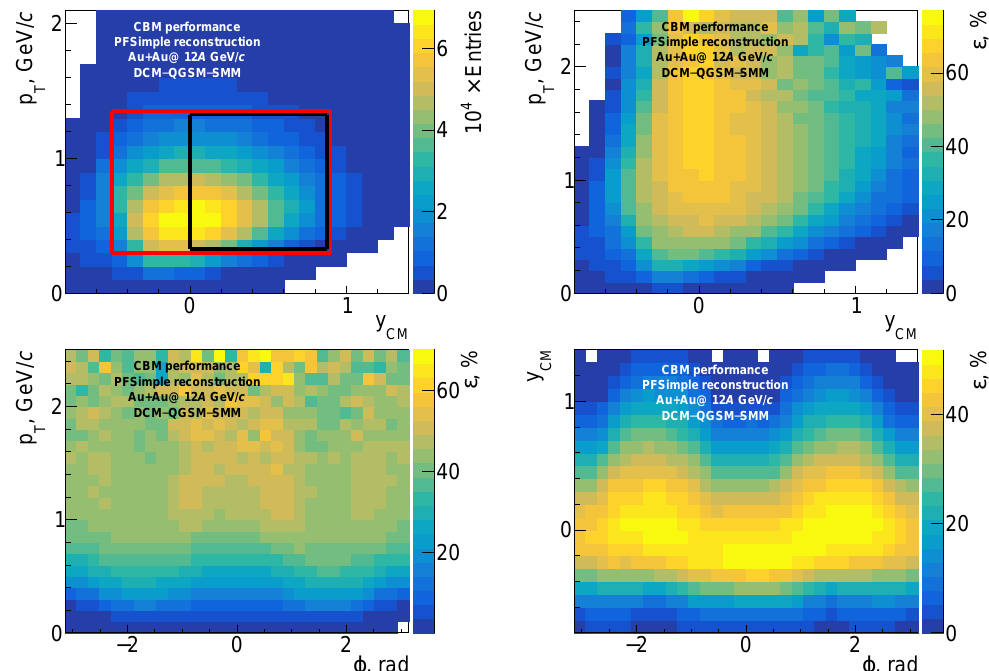
Figure 3. ( top left ) Population of reconstructed Λ hyperons vs. p T , Λ and y Λ . The kinematic ranges for which v 1 vs. y Λ ( p T , Λ and centrality) were calculated are indicated by the red (black) rectangle. Reconstruction efficiency for the Λ → p π − decay channel ( top right ) vs. p T , Λ and y Λ , ( bottom left ) vs. p T , Λ and ϕ Λ and ( bottom right ) vs. y Λ and ϕ Λ